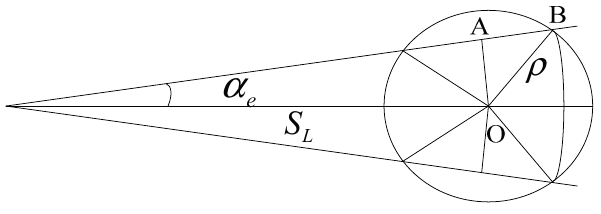
Figure 3. Positioning error influenced by heading and voyage